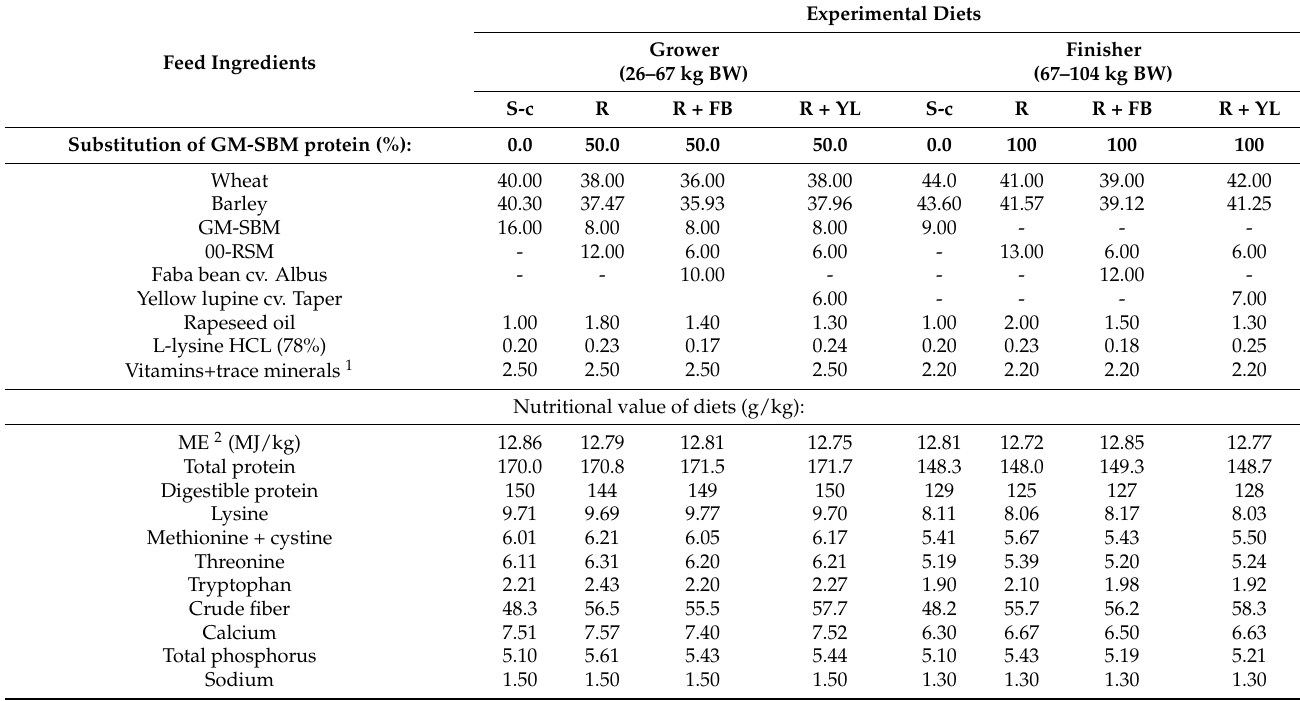
Table 3. Composition and nutritional value of complete diets for growing-finishing pigs (Experiments IA, IB, and II).